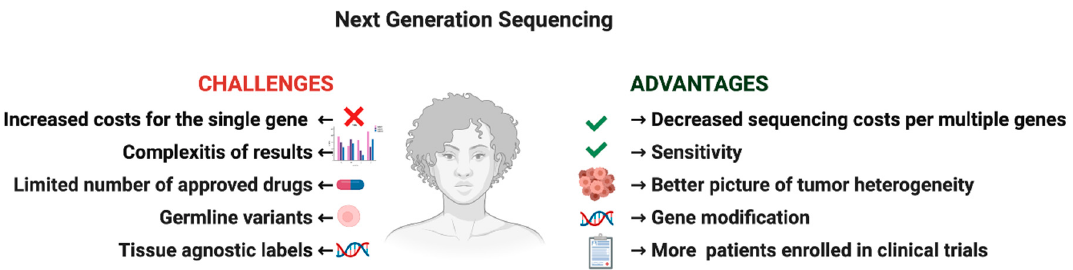
Figure 1. Next-generation sequencing: Advantages and pitfalls.